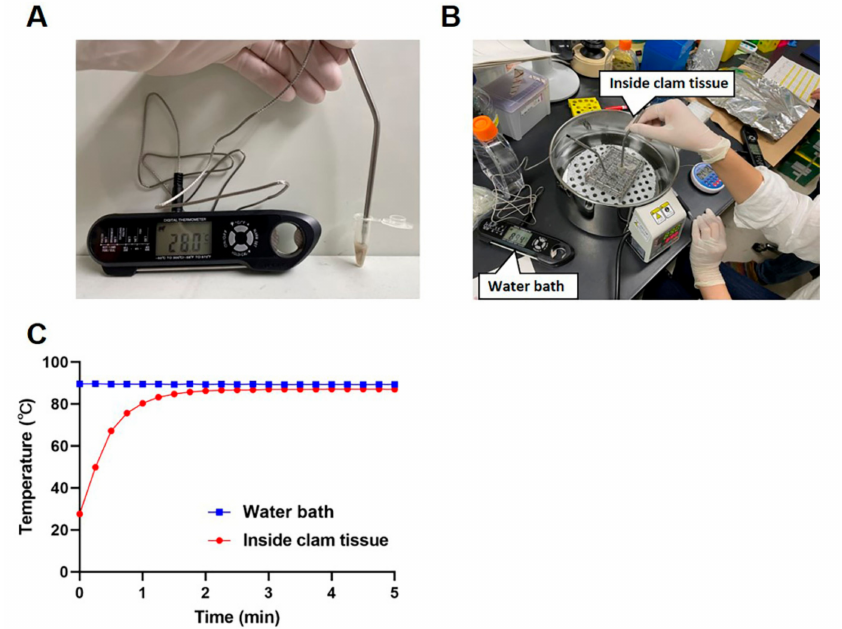
Figure 1. Kinetics of the internal temperature in clams subjected to heat treatment. A thermometer probe was inserted into a clam body in a 1.5-mL tube to measure the internal temperature of the clam ( A ). A second thermometer probe was put in the water bath to measure the temperature outside the 1.5-mL tube ( B ). The internal clam tissue temperature and the external water bath temperature were recorded every 15 s up to 5 min ( C ). The results are shown as the mean ± standard deviation calculated from 5 independent experiments ( n =